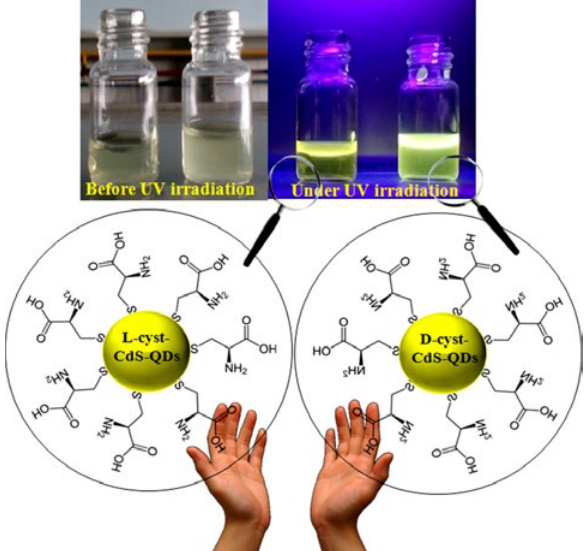
Fig. 1. Representative structures of the L- and D-cyst-CdS-QDs and their emission under UV